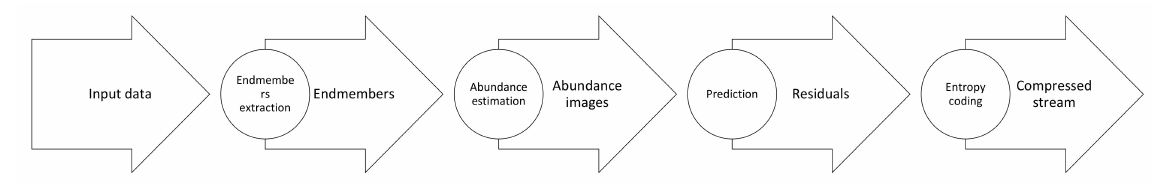
Figure 12. Main steps needed in the unmixing-based compression class of